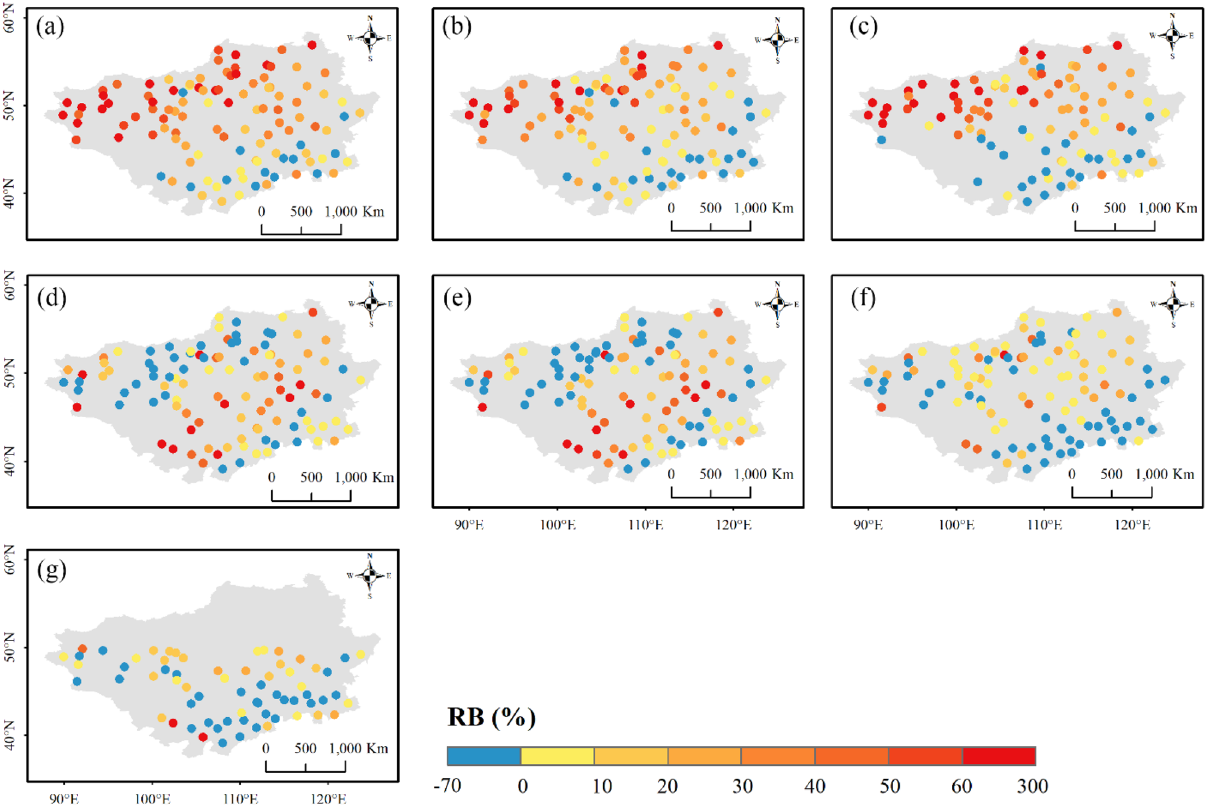
Figure 9. Spatial distribution of RB for ( a ) ERA5-Land, ( b ) ERA5-HRES, ( c ) ERA-Interim, ( d ) IMERG ER, ( e ) IMERG LR, ( f ) IMERG FR, and ( g ) TMPA-3B42. For subplot ( g ), only stations within the spatial coverage of TMPA-3B42 (50° N–50° S) were plotted. The figure was created using ArcGIS 10.7 (https:// www. esri. com/ en- us/ arcgis/ about- arcgis/ overv iew) 70